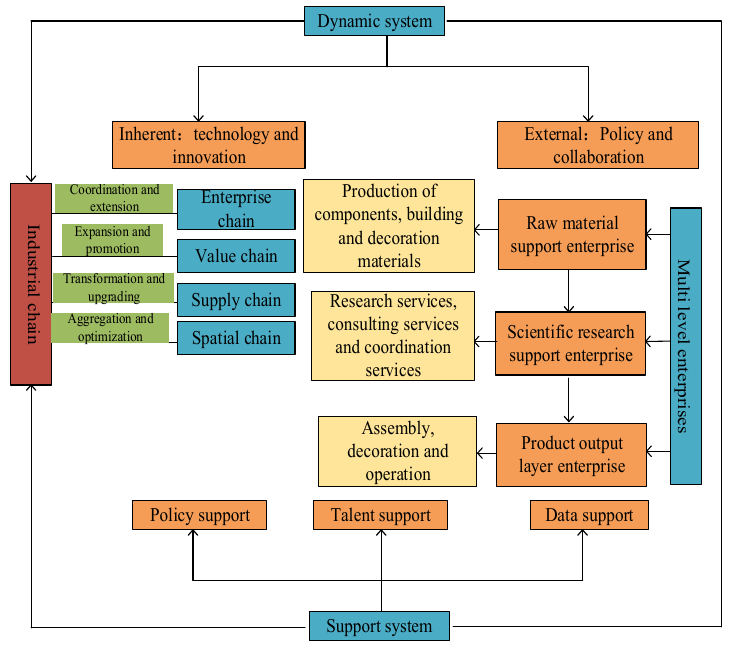
Figure 3. Composition of the industry chain of industrialized